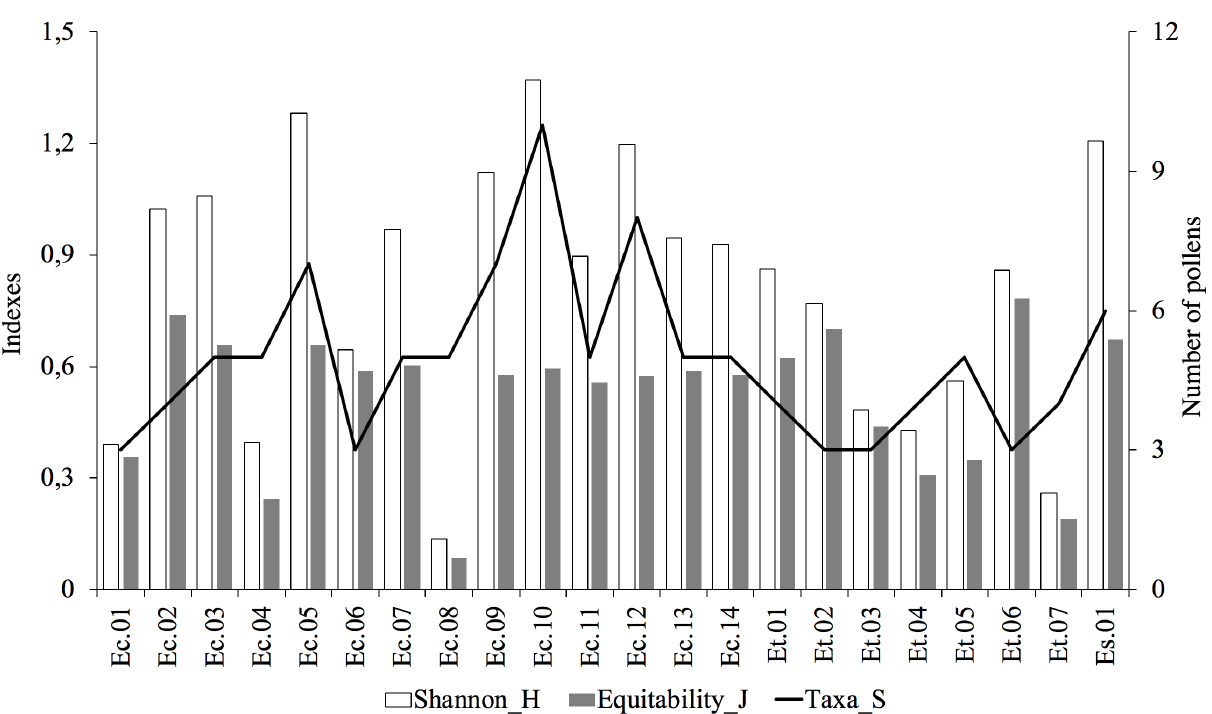
Fig 3 . Richness (S), Diversity Index (H’) and Equitability (J’) of pollen grains found in Euglossa cordata (Ec.01 – Ec.14) and Euglossa townsendi (Et.01 to Et.07)